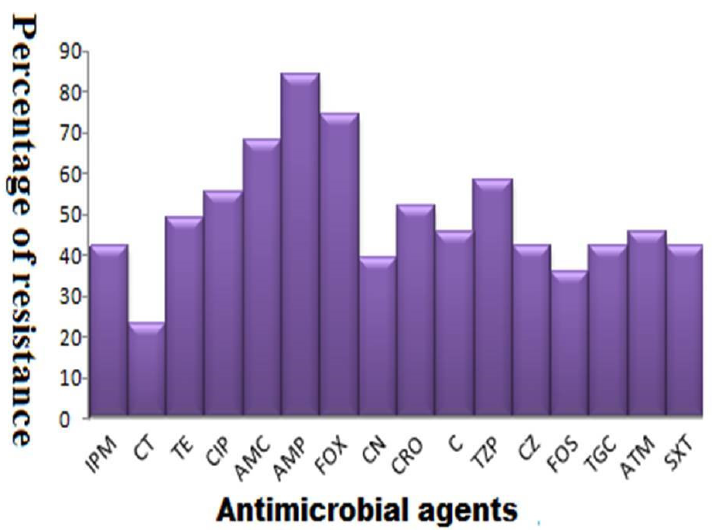
Figure 1. Antimicrobial susceptibility patterns of S. Enteritidis strains. IPM: imipenem, CT: